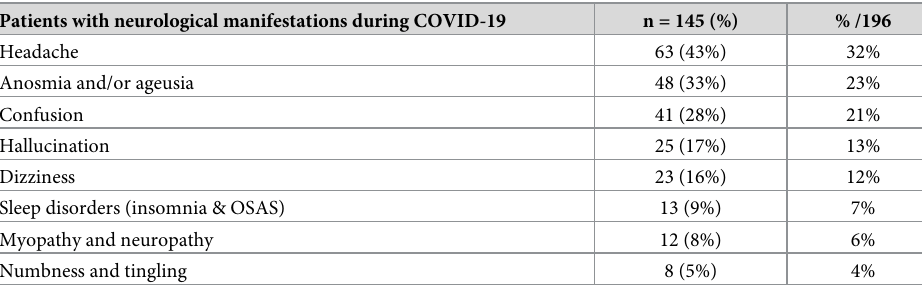
Table 3. Neurological manifestations. Patients with neurological manifestations during COVID-19 n = 145 (%) % /196 Headache 63 (43%) 32% Anosmia and/or ageusia 48 (33%) 23% Confusion 41 (28%) 21% Hallucination 25 (17%) 13% Dizziness 23 (16%) 12% Sleep disorders (insomnia & OSAS) 13 (9%) 7% Myopathy and neuropathy 12 (8%) 6% Numbness and tingling 8 (5%) 4% Table 3 shows different neurological manifestations among study population. The middle column shows the number of positive cases in regard to each variable and the percentage among total number of patients with neurological manifestation (n = 145). The column to the right shows the percentage among the total number of study patients (n = 196). OSAS = Obstructive Sleep